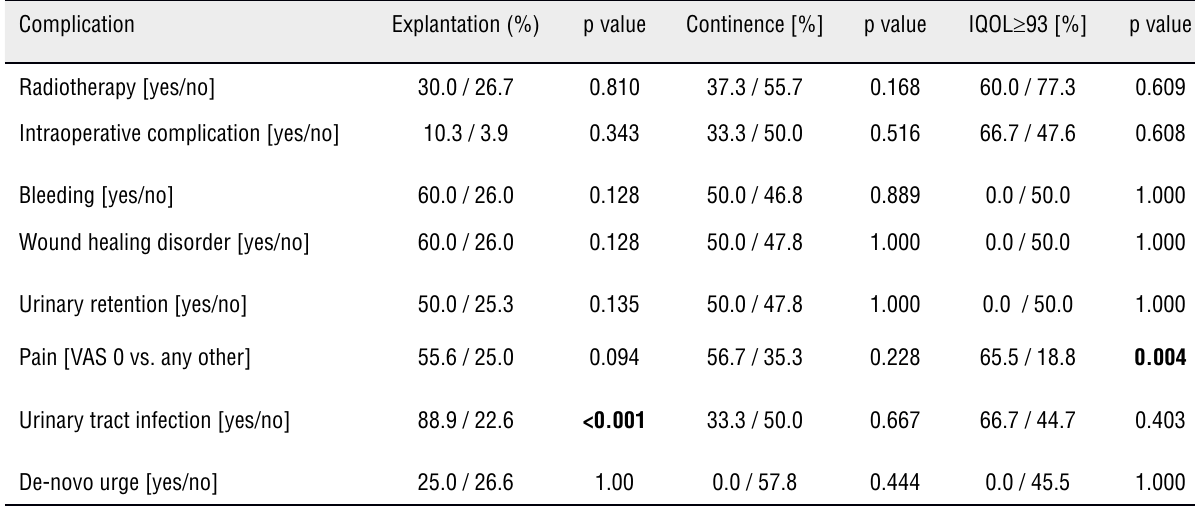
Table 2 - Univariate analysis of the effect of selected perioperative complications on postoperative explantation rates, continence rates, and health-related quality of life based on the validated I-QOL score after a median follow-up of 38 months. The I-QOL cut-off score of 93 is based on the median score of the entire